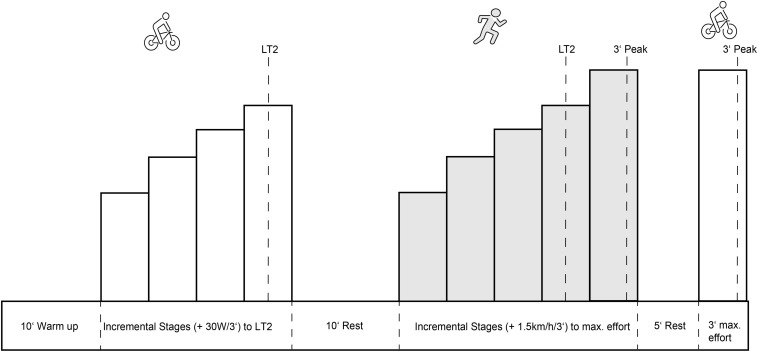
Exercise test design: Participants did a sub-maximal incremental stages test (+25–30W/3’) on the bike and a maximal incremental stages-test (+1.5 km/h/3’) on the treadmill. Participants finished the test procedure with a maximal 3’ effort on the bike (Peak). Included in the test procedure was a 10’ warm-up, 10’ rest between the incremental stages-tests and a 5’ rest period before the final all-out test. LT, lactate threshold; Peak, peak performance.